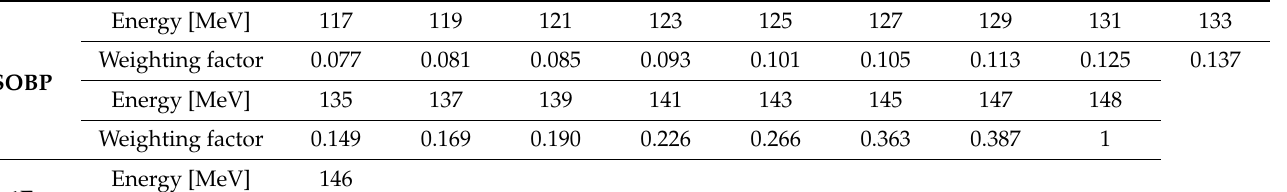
Table 1. Proton energies simulated for 4 different longitudinal irradiation modes. The table lists the used energies and the corresponding relative weighting factors for the depth-dose curves from one direction. Note that the relative weighting factors are only valid within the same depth-dose curve and cannot directly be compared between the scenarios.